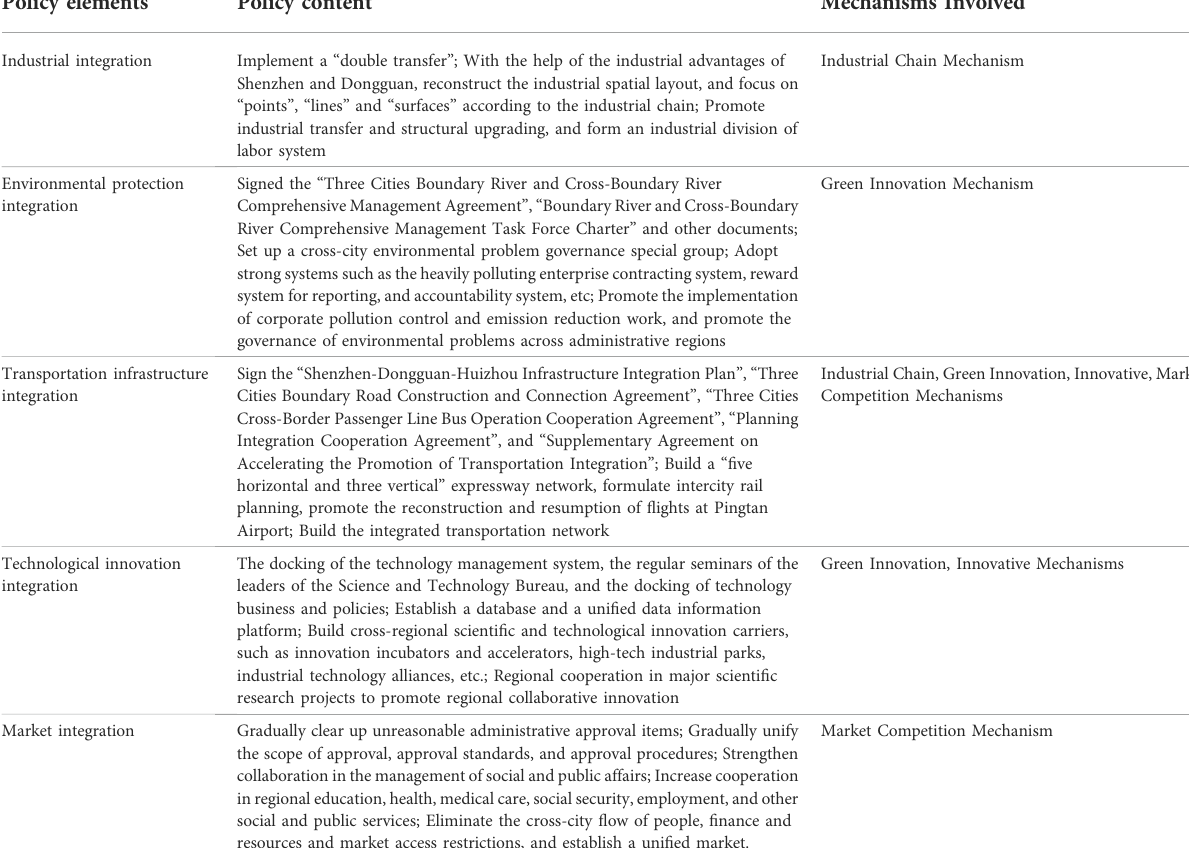
TABLE 1 Main integration policy elements of the